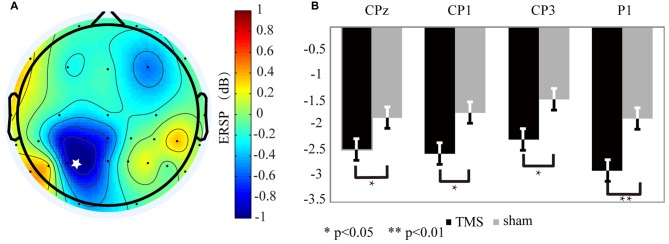
The alpha oscillation variation for the rTMS and sham conditions. (A) The alpha oscillation mapping was obtained by subtracting the sham condition from the rTMS. From the map, only the left parietal area exhibited decreased power. In contrast, power increased in the contralateral region. The “*” symbol represents the stimulation location. (B) The electrodes showing significantly different readings included CP1 (P < 0.03*), P1 (P < 0.01**), CP3 (P < 0.04*), and CPz (P < 0.05*).